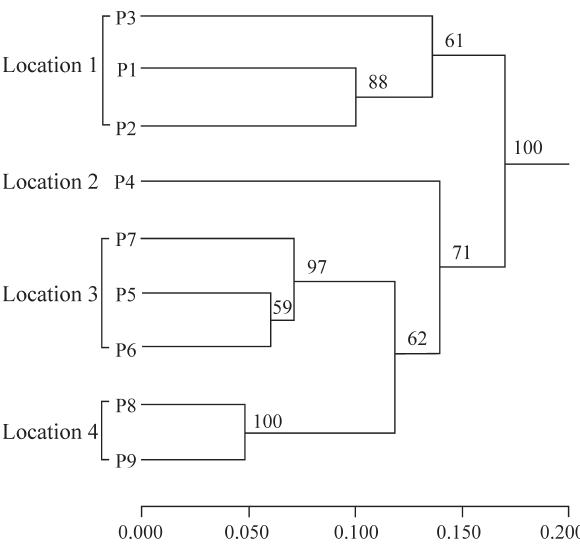
Figure 2 - Dendrogram showing the relationships between nine Rhodiola crenulata populations. The dendrogram was generated using the un- weighted pair-group method with arithmetic averages (UPGMA) method using the genetic distances matrix based on 184 inter-simple sequence re- peat (ISSR) markers produced by 12 single primers. Bootstrap support values are indicated above the branches.